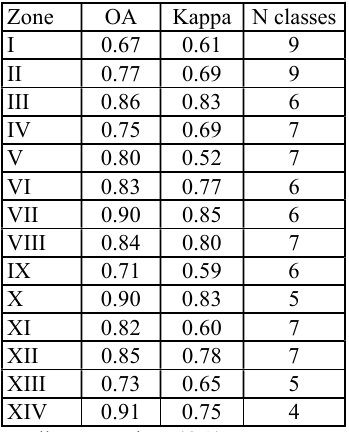
of zone III, zone IV, North of zone VI and zone VII. Zone VIII show a pattern with no dominance of cropland or no cropland classes with mixed patches of natural woody vegetation. Also it is possible to identify large rangeland dominated areas with a clear limit with cropland dominated areas (Zones X, XI and XII). Northern regions show high proportion of natural